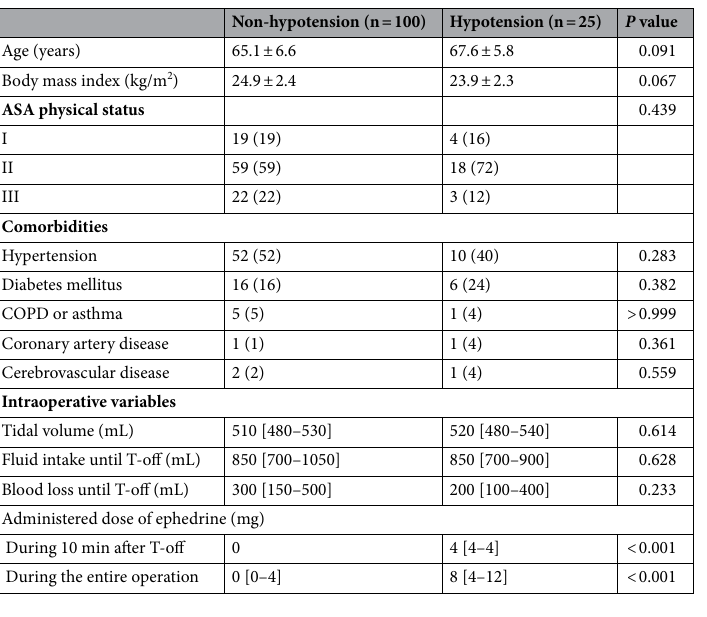
Table 1. Patients’ characteristics and intraoperative variables. Values are presented as mean ± standard deviation, number of patients (%), or median [interquartile range]. ASA American Society of Anesthesiologists; COPD chronic obstructive pulmonary disease; T-off postural change from the Trendelenburg position to the supine